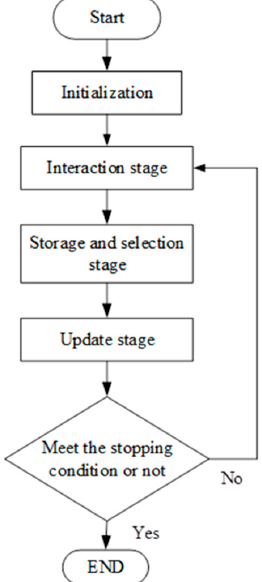
Figure 9. Flowchart of deep principal component analysis network (DPCANet).